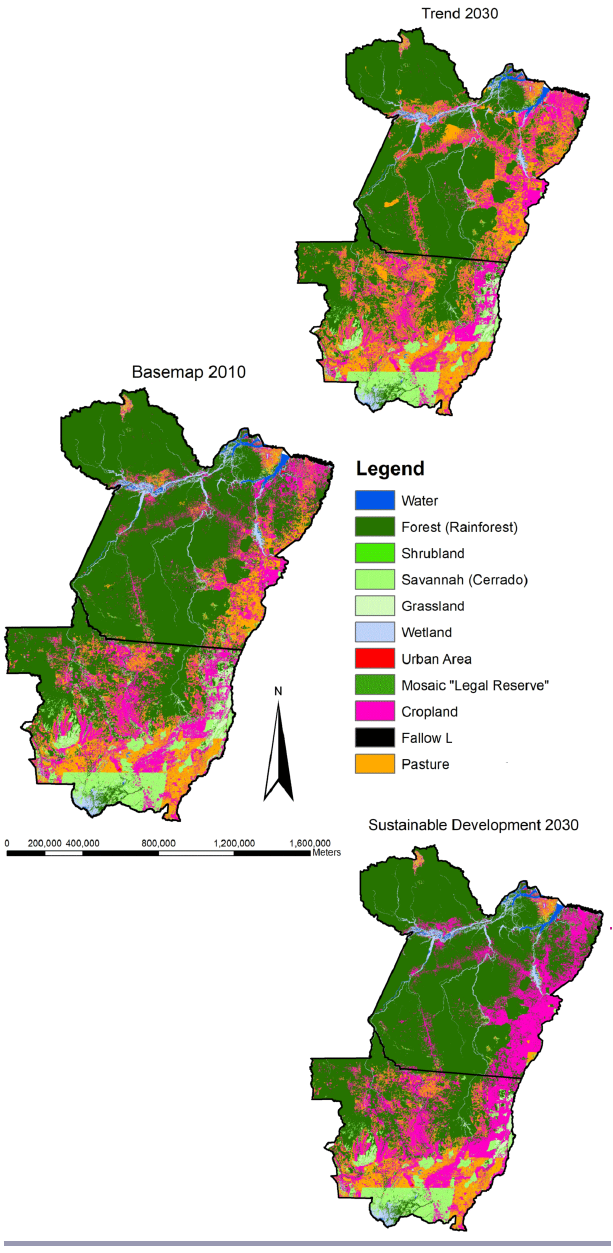
Fig. 2 . State level land-use